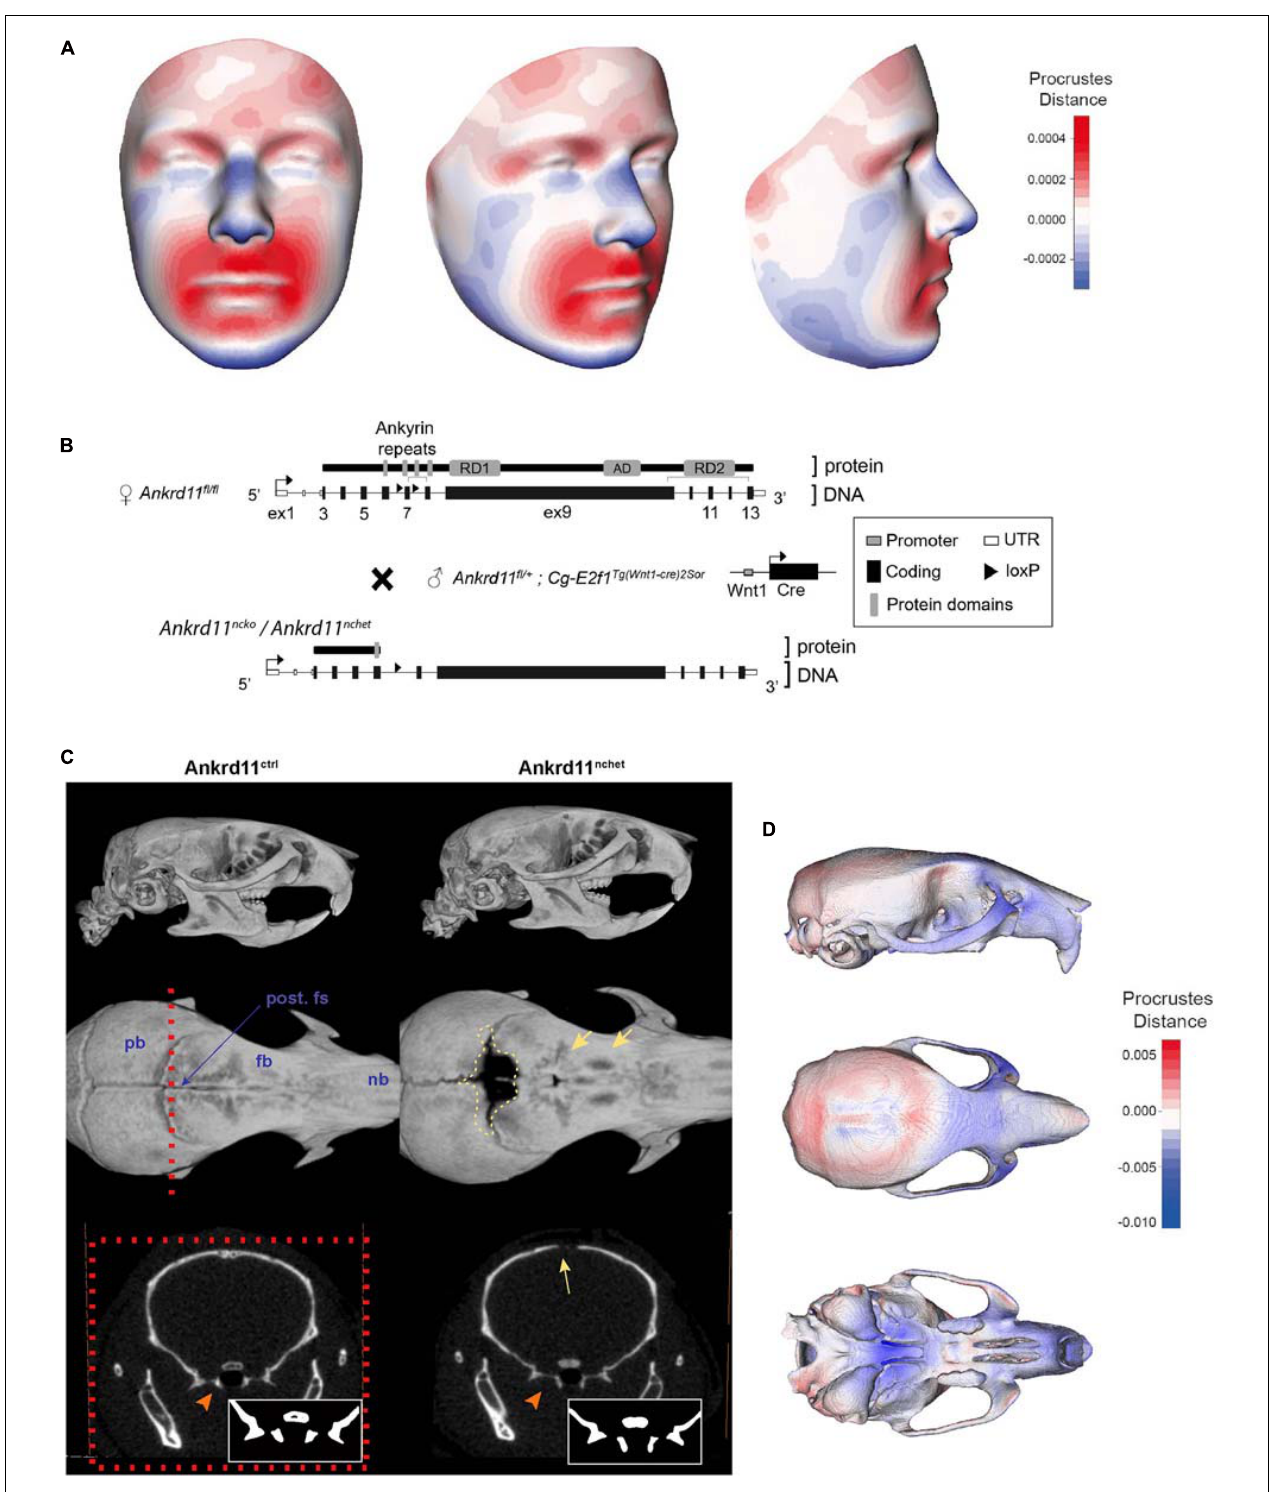
FIGURE 1 | KBG syndrome patients and Ankrd11 nchet mice share craniofacial similarities. (A) Mesh morphometric analysis of 4 KBG syndrome patient 3D images. Images shown are a mean representation of craniofacial changes on a reference face. Heat map representation in Procrustes distance (relative to superimposition). Red color indicates positive change in size relative to reference mesh and blue indicates negative size difference. White color indicates no change in highlighted region. (B) Brief summary of gene targeting and breeding strategy to produce Ankrd11 nchet mice, shown in panels (C,D) , and Ankrd11 ncko mice. (C)